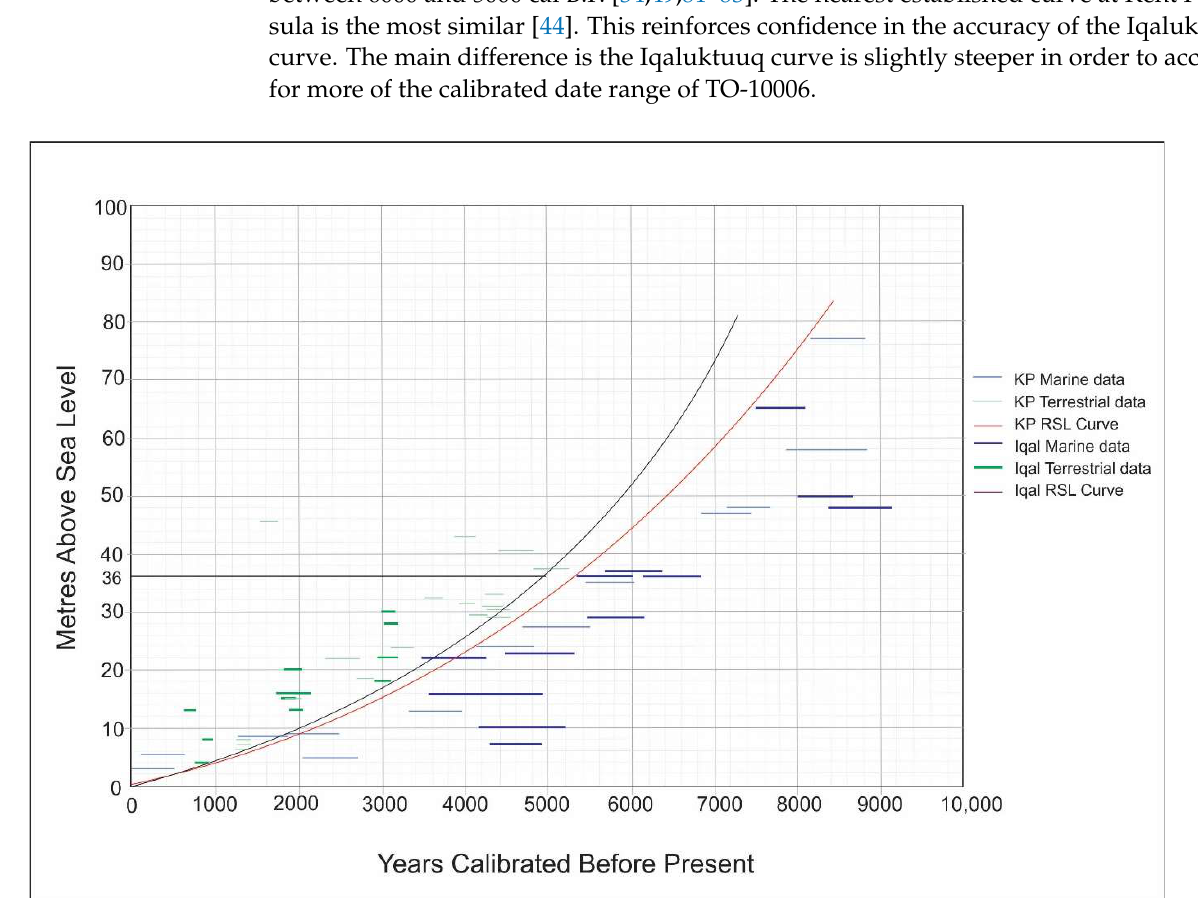
Figure 3. Relative sea-level curves for Kent Peninsula (KP) and Iqaluktuuq (Iqal). Barring elevation or age anomalies, dates on marine materials (blue bar) should fall on or below the relative sea-level curve and dates on archaeological materials (green bar) should fall on or above the curve.